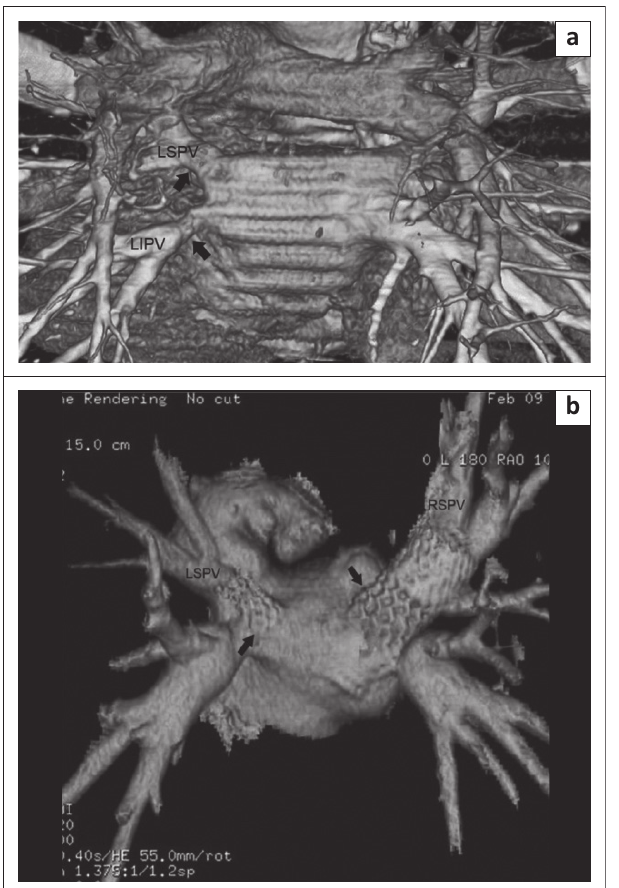
LSPV, left superior pulmonary vein; RSPV, right superior pulmonary vein. FIGURE 12: (a) A three-dimensional model of a patient: post radiofrequency ablation for atrial fibrillation showing minor stenoses in the left superior and left inferior pulmonary veins (arrow); (b) A three-dimensional model of another patient: post ablation shows stenoses in the right and left superior pulmonary veins severe enough to require stent insertion (arrow).